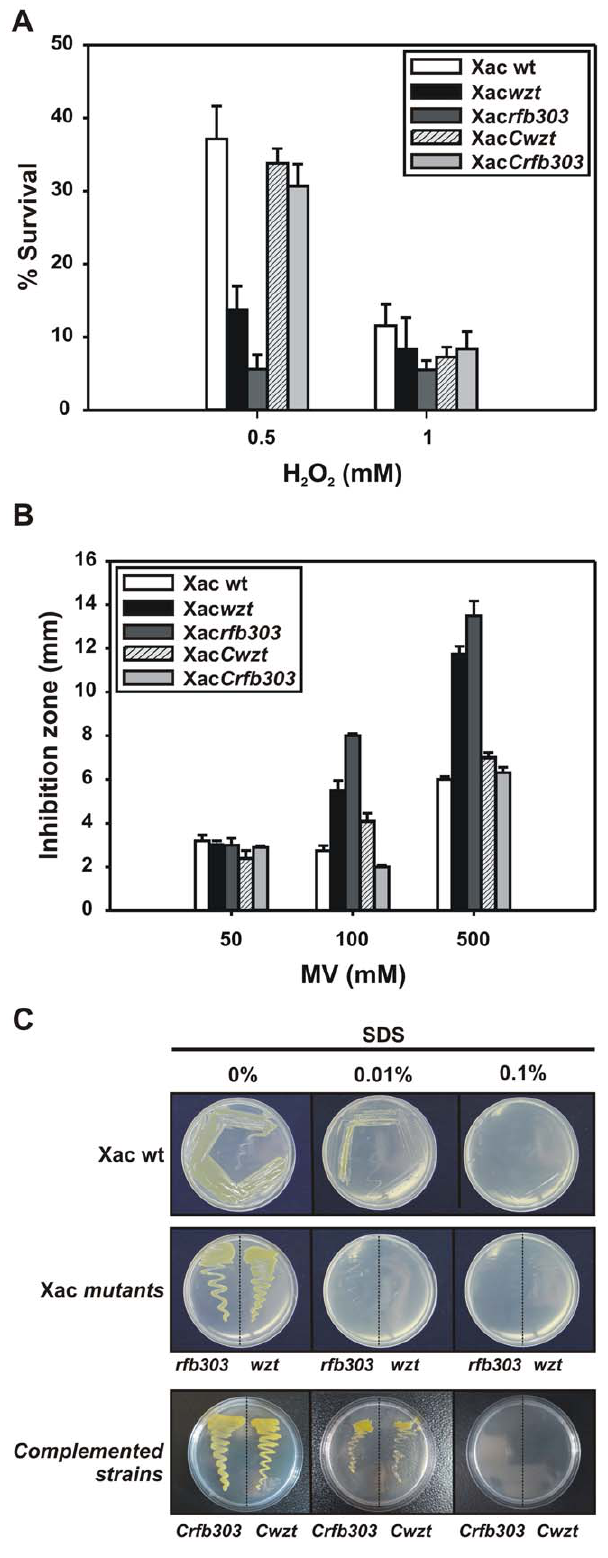
Figure 2. Sensitivity of Xac wild-type, Xac wzt and Xac rfb303 to oxidative stress and SDS. (A) Hydrogen peroxide resistance of bacterial cultures. Cells in early exponential phase of growth were exposed to the indicated concentrations of H 2 O 2 for 15 min. The number of CFU was determined for each culture before and after